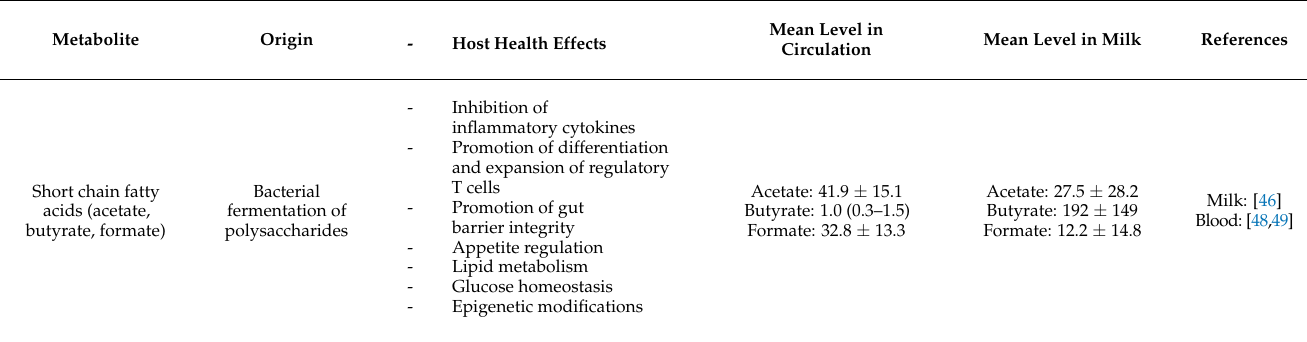
Table 1. Key health-modulating gut bacterial metabolites that have been identified in human milk. Previously reported levels from blood and milk samples are provided. Values are mean ± SD, or mean (range), depending on the reporting style of the study. Concentrations are µ M unless stated